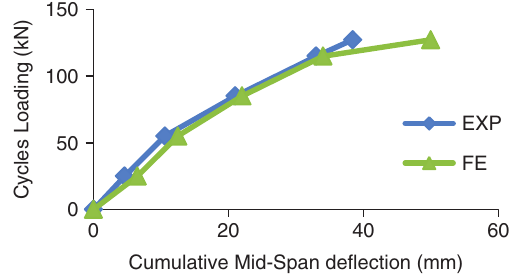
Fig. 21. Load against de fl ection curves for the pre-repair phase of the beam G4R3